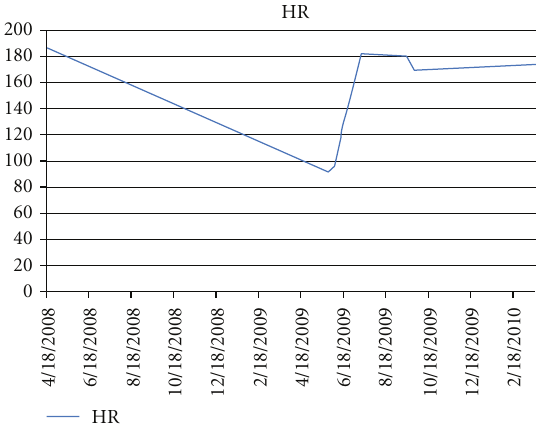
Figure 3: Peak heart rate response to exercise pre- and post-